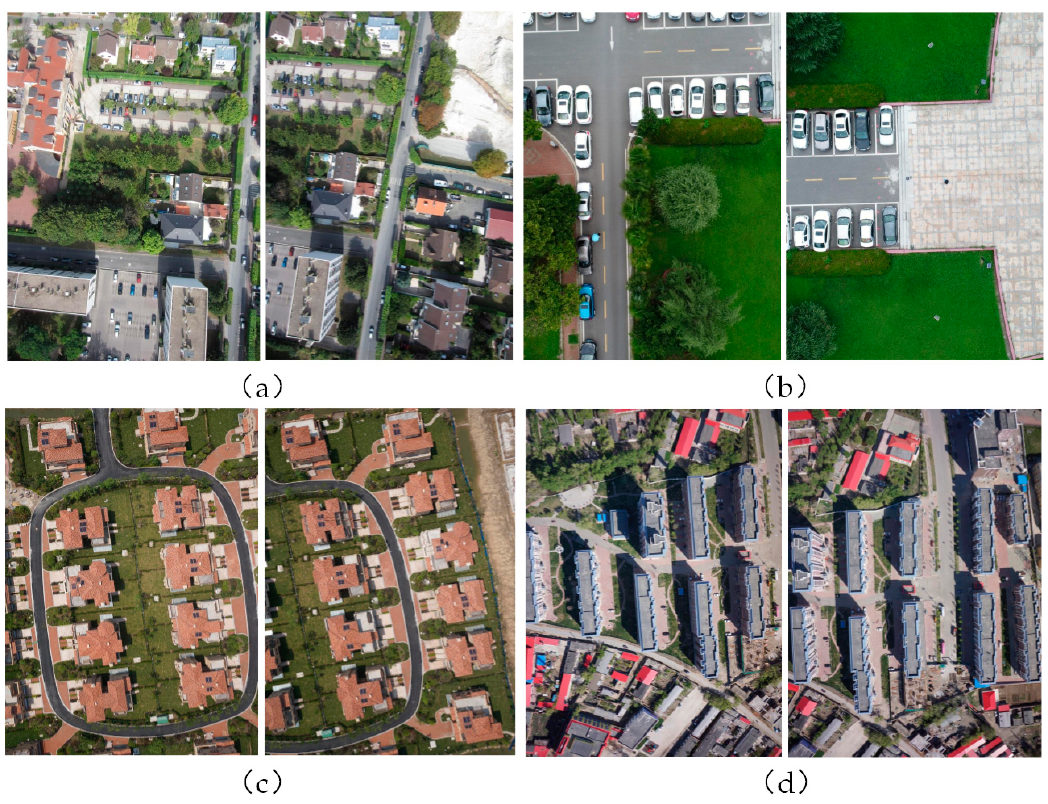
Figure 5. Four UAV image pairs. ( a ) The first pair. ( b ) The second pair. ( c ) The third pair. ( d ) The fourth pair.